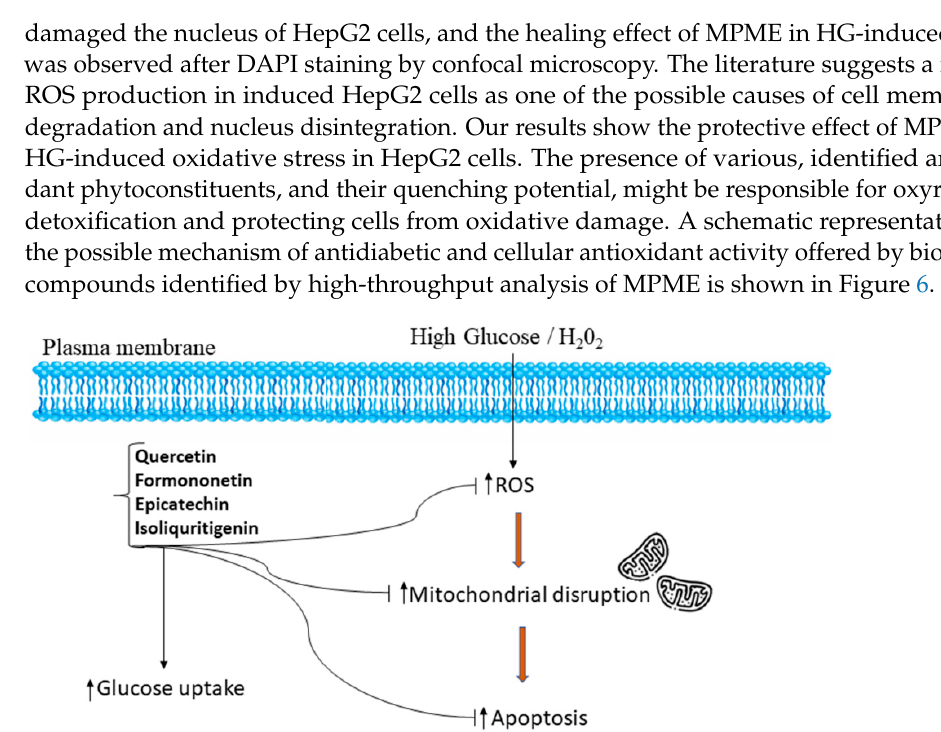
Figure 6. Schematic representation of the mechanism of potential antidiabetic and cellular an- tioxidant activities conferred by bioactive compounds such as epicatechin, quercetin, isoliquiriti- genin, and formononetin identified by UPLC-MS and HPTLC analysis from a heartwood extract of Pterocarpus marsupium . The identified bioactive compounds relieve oxidative stress and attenuate apoptosis by regulation of ROS in a high glucose, H 2 O 2 -induced environment in HepG2 cells [48,49].